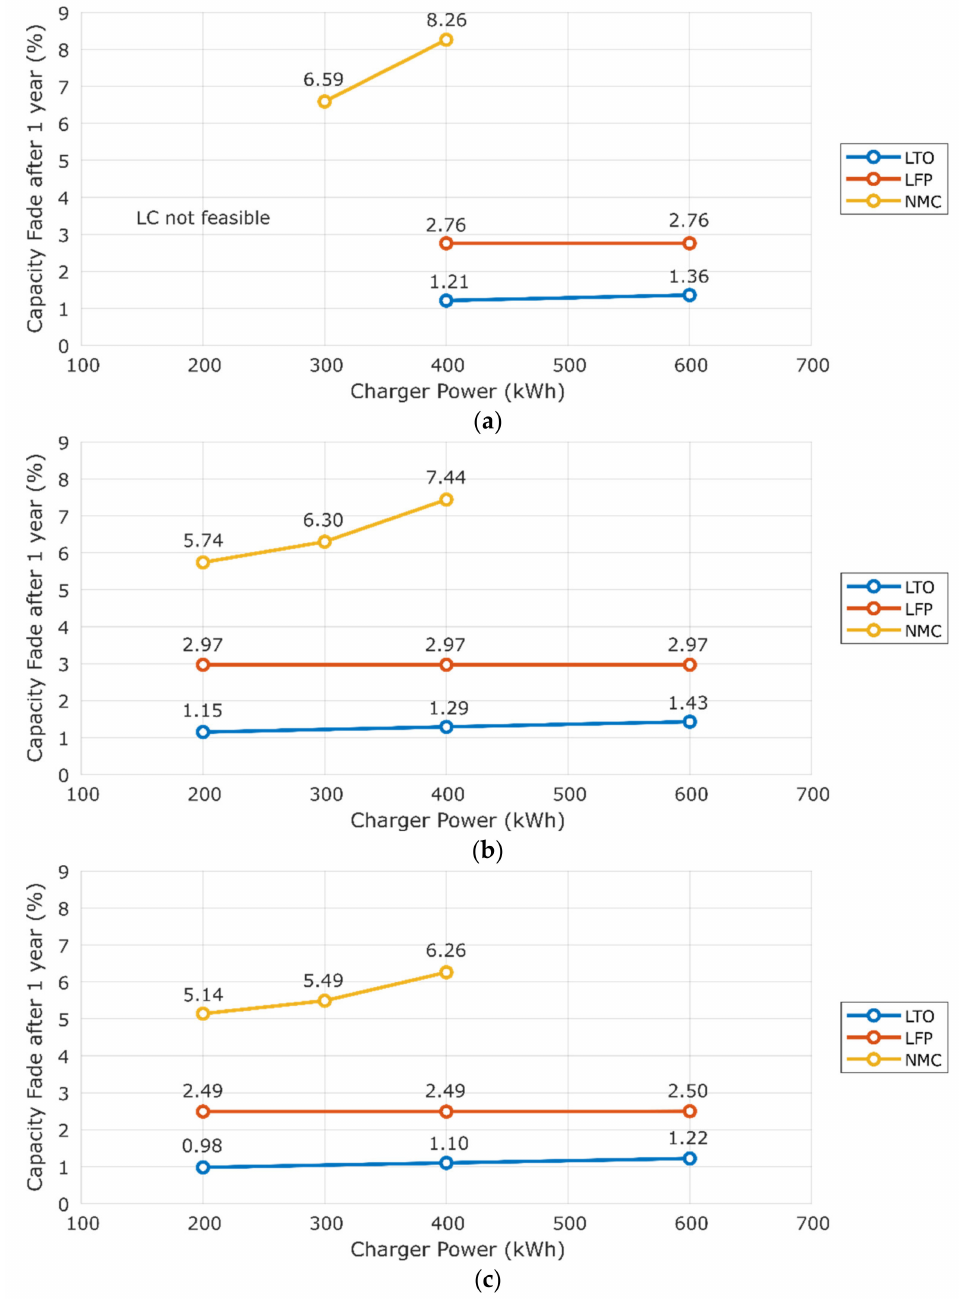
Figure 8. CF y in the different case studies and scenarios (bus lines). ( a ) Barcelona bus line. ( b ) Osnabrück bus line. ( c ) Gothenburg bus